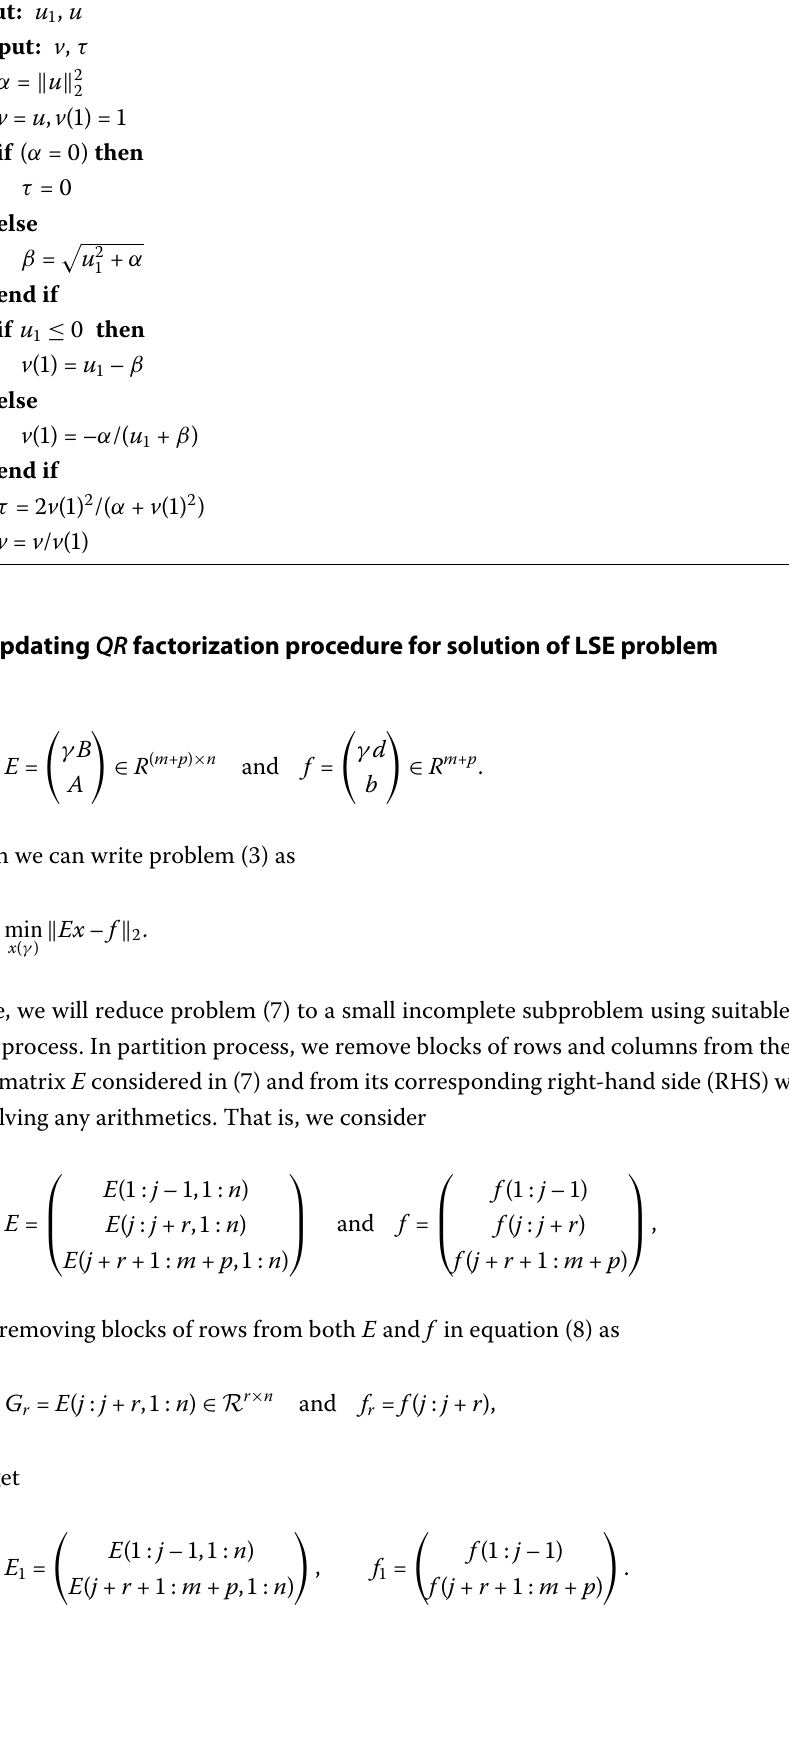
Algorithm  Computation of parameter τ and Householder vector v